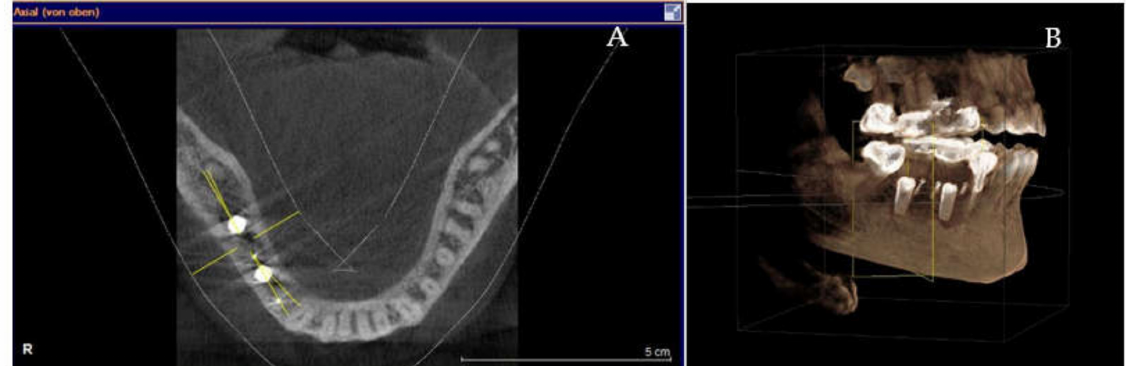
Figure 7. ( A , B ) 7-months follow-up of S-GBR surgery. ( A ) CBCT shows 2 mm bone around implants. ( B ) CBCT shows reduced bone resorption in the coronal area of implants.